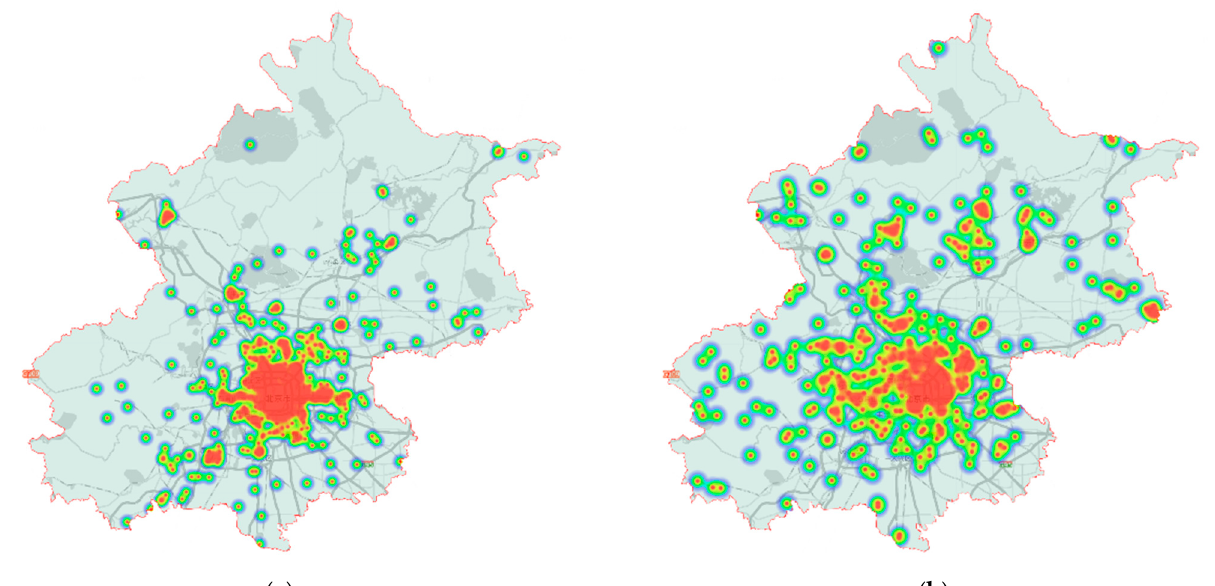
Figure 10. ( a ) Geographical distribution of user markers (before the outbreak); ( b ) geographical distribution of user markers (during the outbreak).